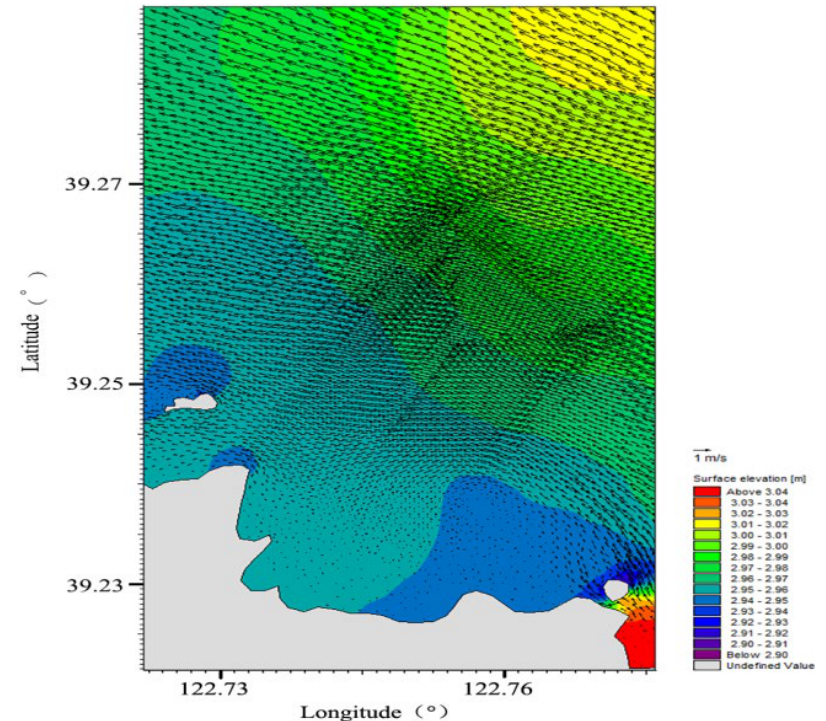
Figure 10. Flow field distribution at the peak of an ebb tide.